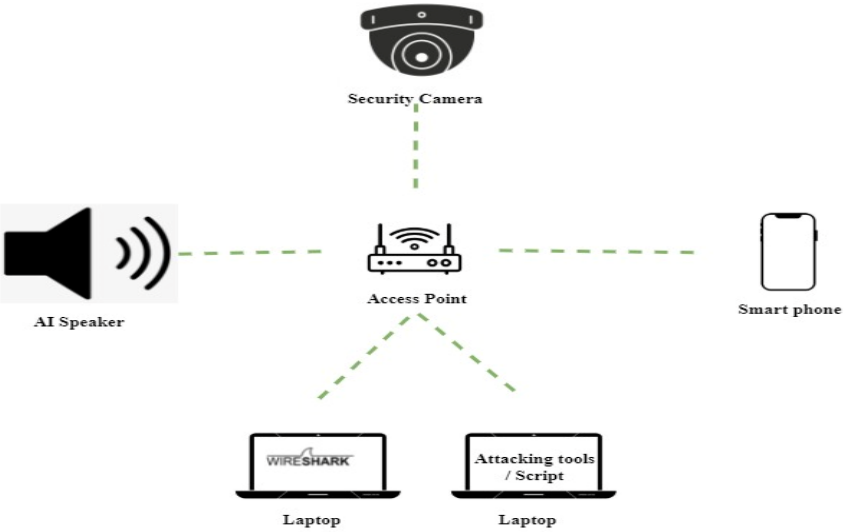
Figure 2. The IoTID20 dataset testbed environment.